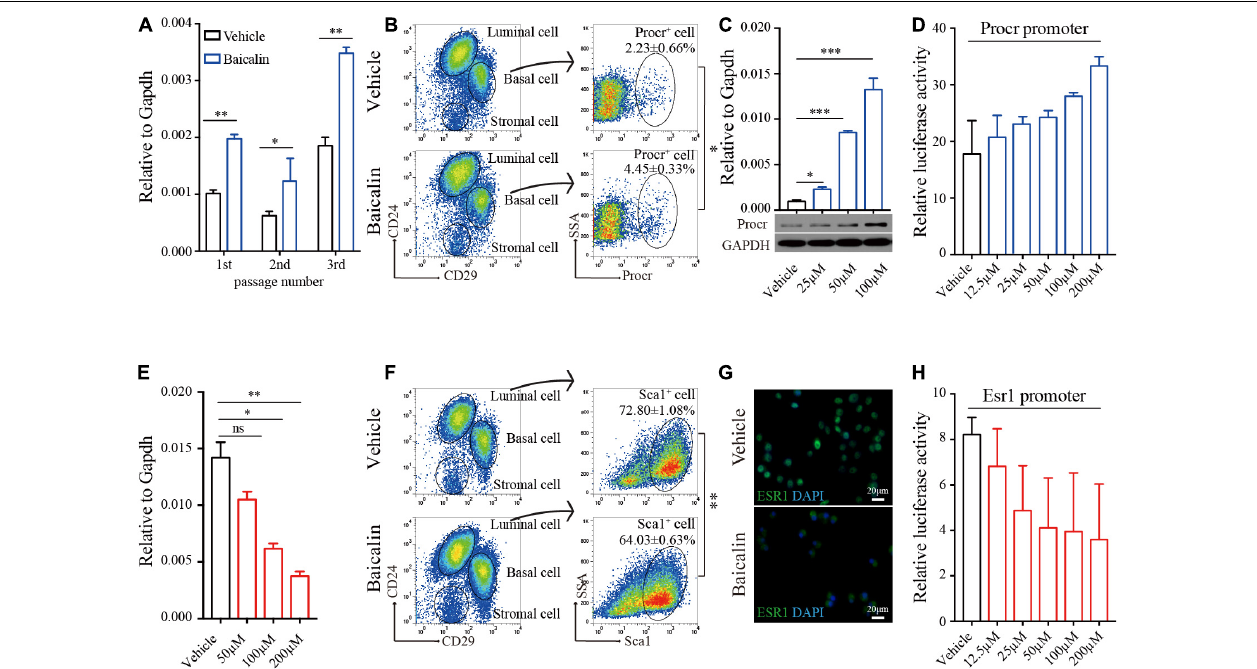
FIGURE 4 | Baicalin up-regulates Procr expression and down-regulates Esr1 expression. (A) RT-qPCR analyses were performed to detect Procr expression in basal cells after different numbers of serial passages. Data are presented as mean ± SD from three independent experiments. Student’s t -test: ** P < 0.01; * P < 0.05. (B) FACS of mammary epithelial cells to determine the percentage of Procr + basal cells in C57BL/6 mice. Student’s t -test: * P < 0.05. (C) RT-qPCR and western blot analyses were performed to detect Procr expression in primary cells treated with baicalin. Data are presented as mean ± SD from three independent experiments. Student’s t -test: *** P < 0.001; * P < 0.05. (D) Luciferase assays of Procr promoter activity. Data are presented as mean ± SD from three independent experiments. (E) RT-qPCR analyses were performed to detect Esr1 expression in luminal cells. Data are presented as mean ± SD from three